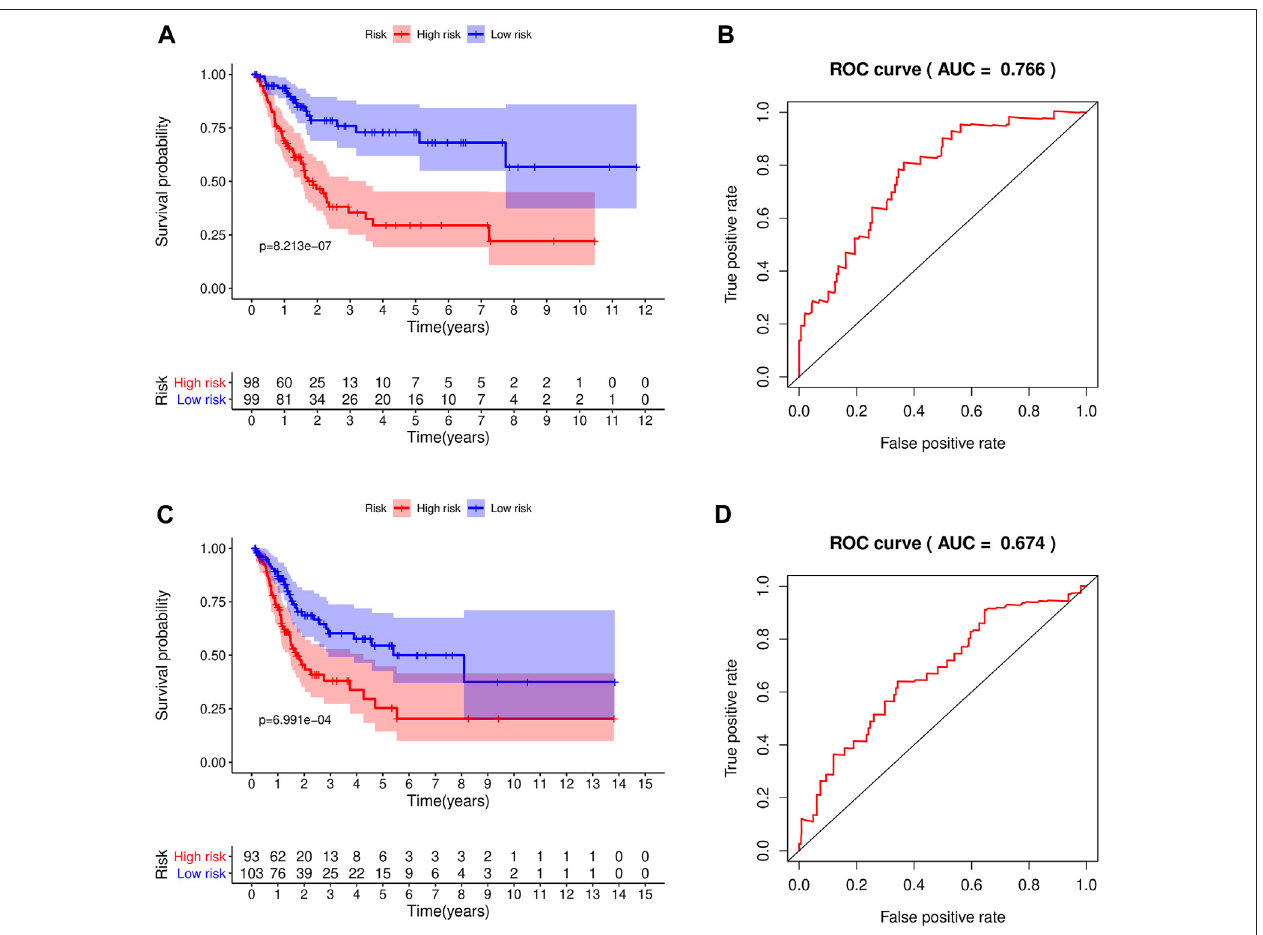
FIGURE 5 | The constructed prognostic model was used for survival analysis of the training set and test set, and ROC was analyzed. (A) Survival analysis curve of the training set; red indicates patients in the high-risk group, blue denotes patients in the low-risk group. (B) ROC curve of the training set. (C) Survival analysis curve of the test set. (D) ROC curve of the test